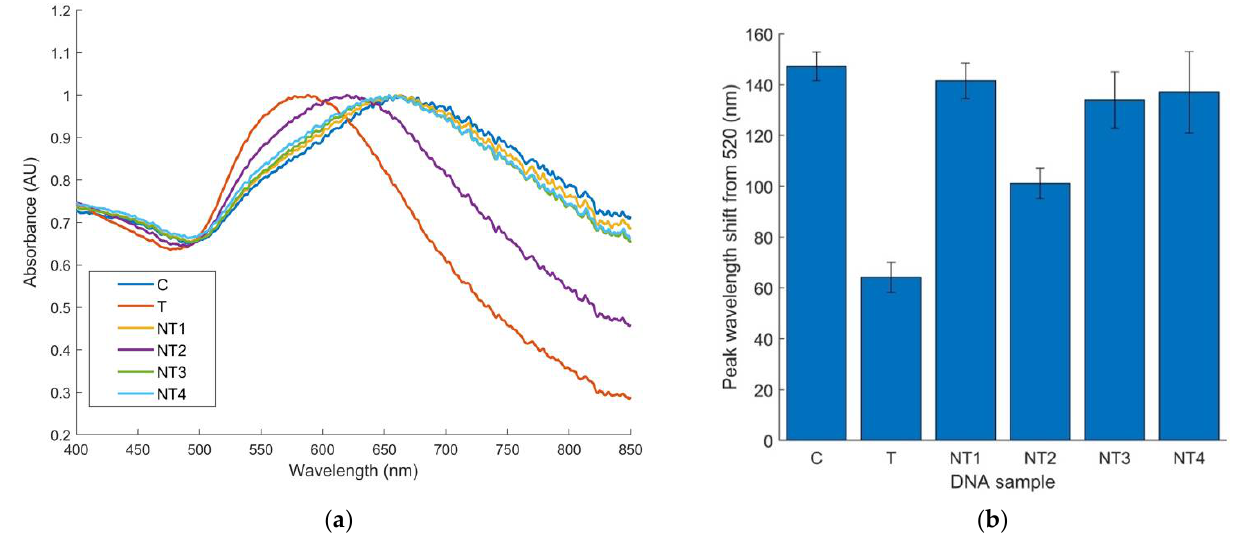
Figure 5. ( a ) Normalized average absorbance spectra for 9 replicates of E. coli O157 biosensor; ( b ) E. coli O157 specificity results analyzed by peak wavelength shift from 520 nm and conducted with 10 ng/µL of DNA, 9 replicates per sample ( n = 9). Error bars represent 95% confidence intervals. (C, water; NT1, E. coli C-3000; NT2, S. Enteritidis; NT3, Listeria spp.; NT4, B. cereus ).